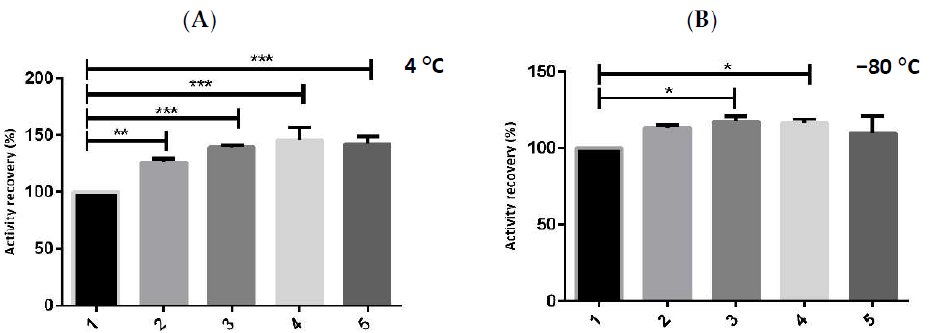
Figure 3. A graphical representation for both ( A , B ) of the activity recovery of the protein lysate: 1—base buffer; 2—base buffer with 10 mM of [Ch][DHP]; 3—buffer 2 with 15 mM of cysteine; hMBCOMT lysate: 1 — base buffer; 2 — base buffer with 10 mM of [Ch][DHP]; 3 — buffer 2 with 15 4—buffer 3 with 5 mM of trehalose and 5—buffer 4 with 5% of glycerol, hMBCOMT lysate storedat 4, mM of cysteine; 4 — buffer 3 with 5 mM of trehalose and 5 — buffer 4 with 5% of glycerol, and − 80 ◦ C for 12 h. ( p -value * <0.05; ** <0.01; *** <0.001). hMBCOMT lysate storedat 4, and −8 0 °C for 12 h. ( p -value * <0.05; ** <0.01; *** <0.001).